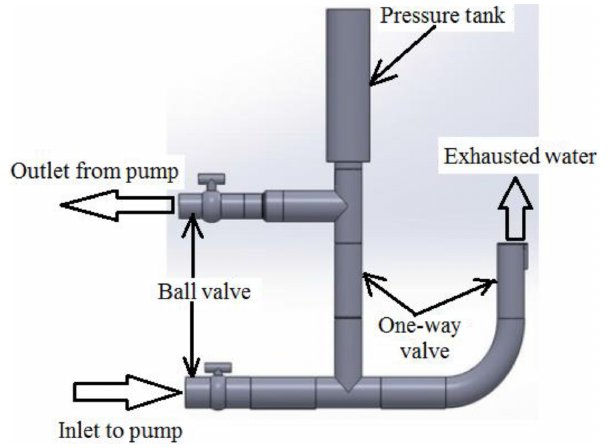
Figure 1. Schematic of the water-hammer head pump.